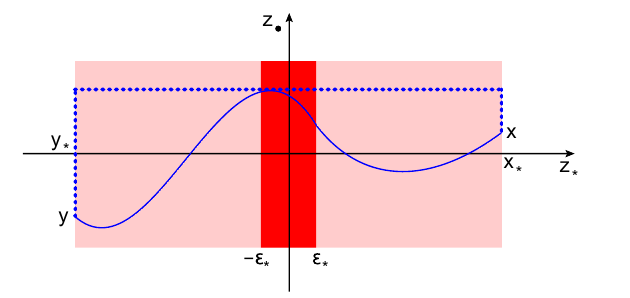
Figure 1. Particle propagating in an external gluonic field. The red strip represents the shock-wave defined in the , ǫ ǫ ] in which F µν (cid:31) 0. The light-red areas to the left and to the right of the shock-wave infinitesimal interval [ − ∗ ∗ represent the background filed made of pure gage field. The curvy line is the particle’s path from point x to point y . The dotted lines represent the Wilson